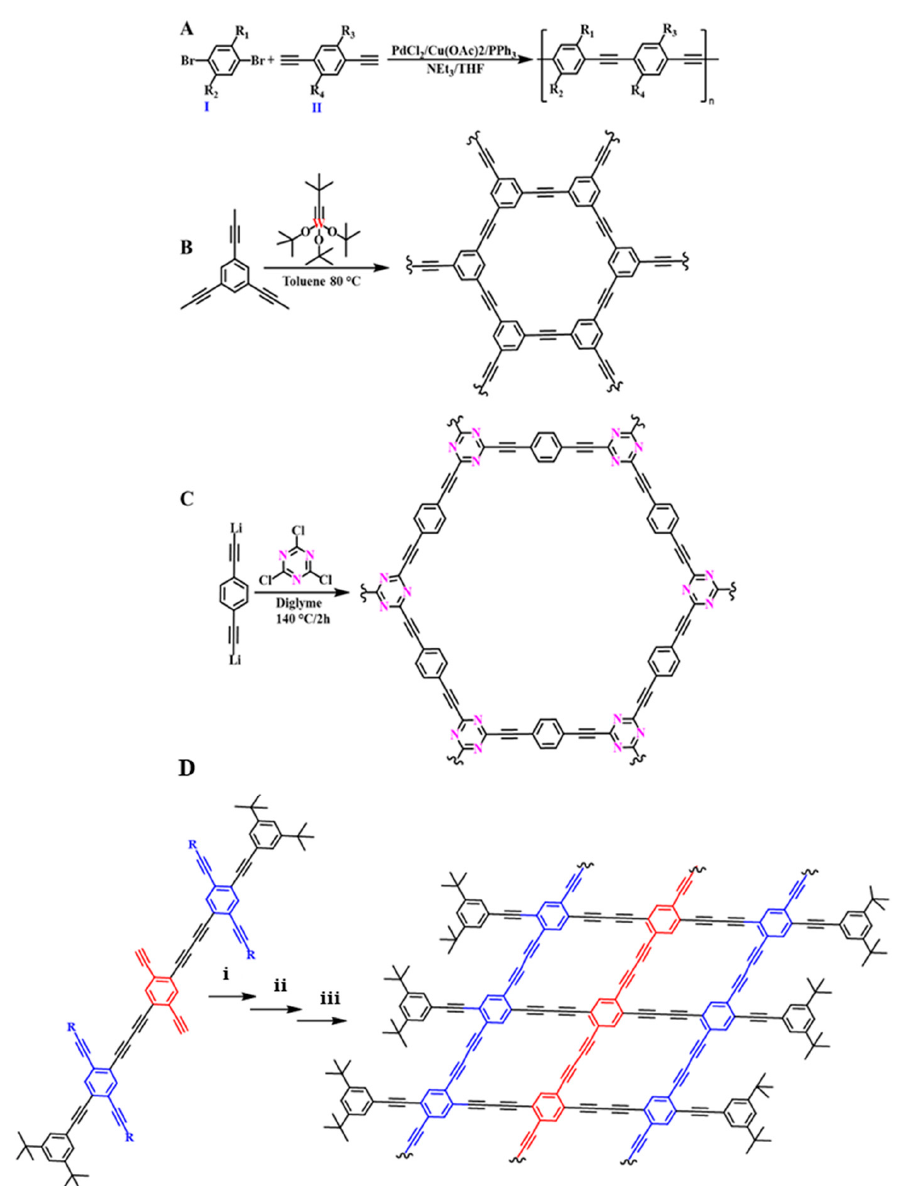
Figure 9. Homogenous coupling reactions in the preparation of graphyne derivatives ( A ). Synthetic scheme of the graphyne ( B ) and N-doped graphyne-like nanostructures ( C ). Redrawn [87,94]. ( D ) Intermolecular Glaser-Hay cross-coupling reactions of red fragments for GDY nanoribbons by copper(I) chloride, TMEDA, and acetone/tetrahydrofuran at RT (i); tetra-n-butylammonium fluoride and THF at RT (ii); intramolecular coupling reaction of blue fragments by Cu(OAc) 2 and pyridine, H 2 O, and CH 2 Cl 2 at RT (iii); R = triisopropylsilyl; TMEDA: N , N , N ′ , N ′ -tetramethylethane-1,2-diamine; RT: room temperature. Redrawn [63,64].